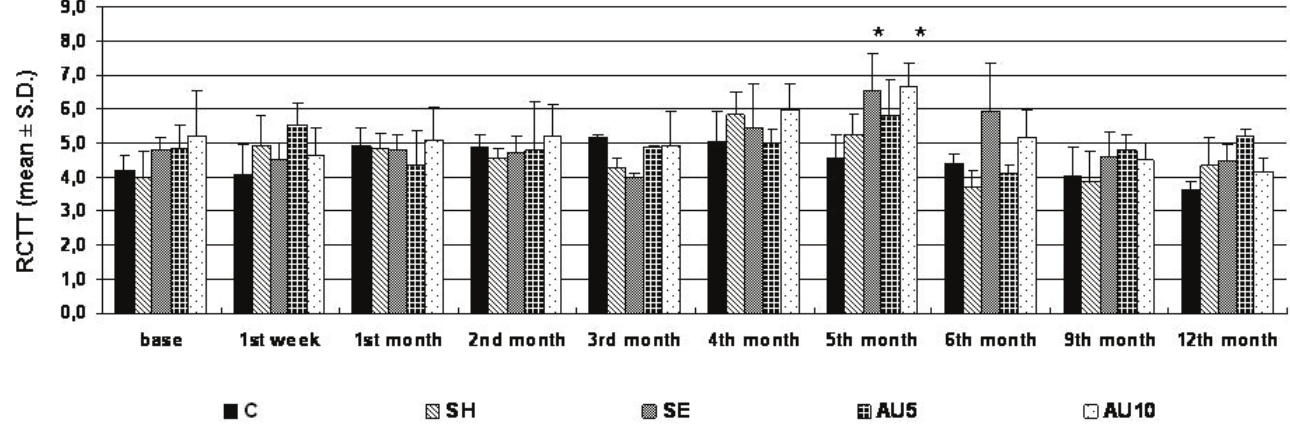
FIGURE 1 - The changes in the relative cell transit time (RCTT) the function of